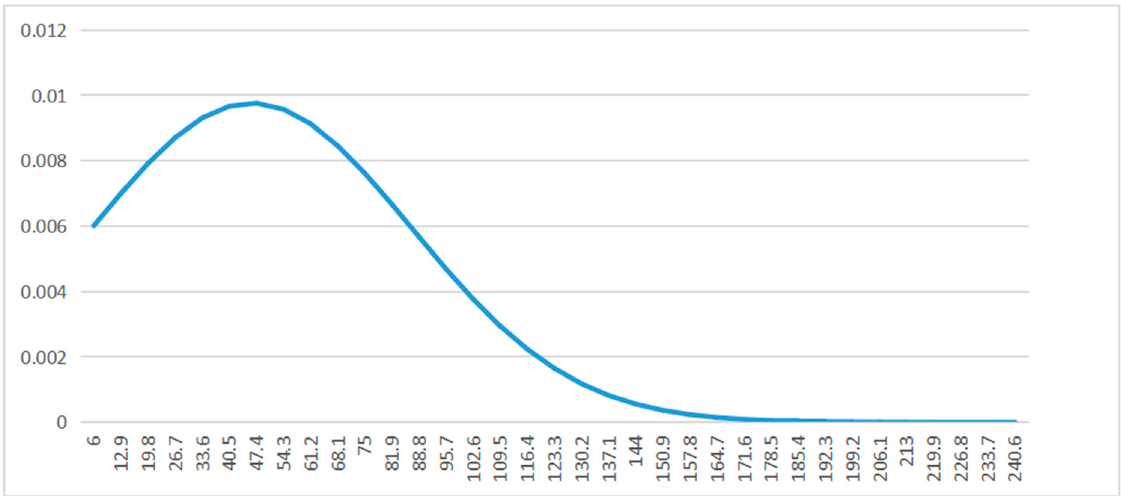
Figure 9. Distribution diagram of CAEIE. The mean length was 46.2. The maximum value was 351.